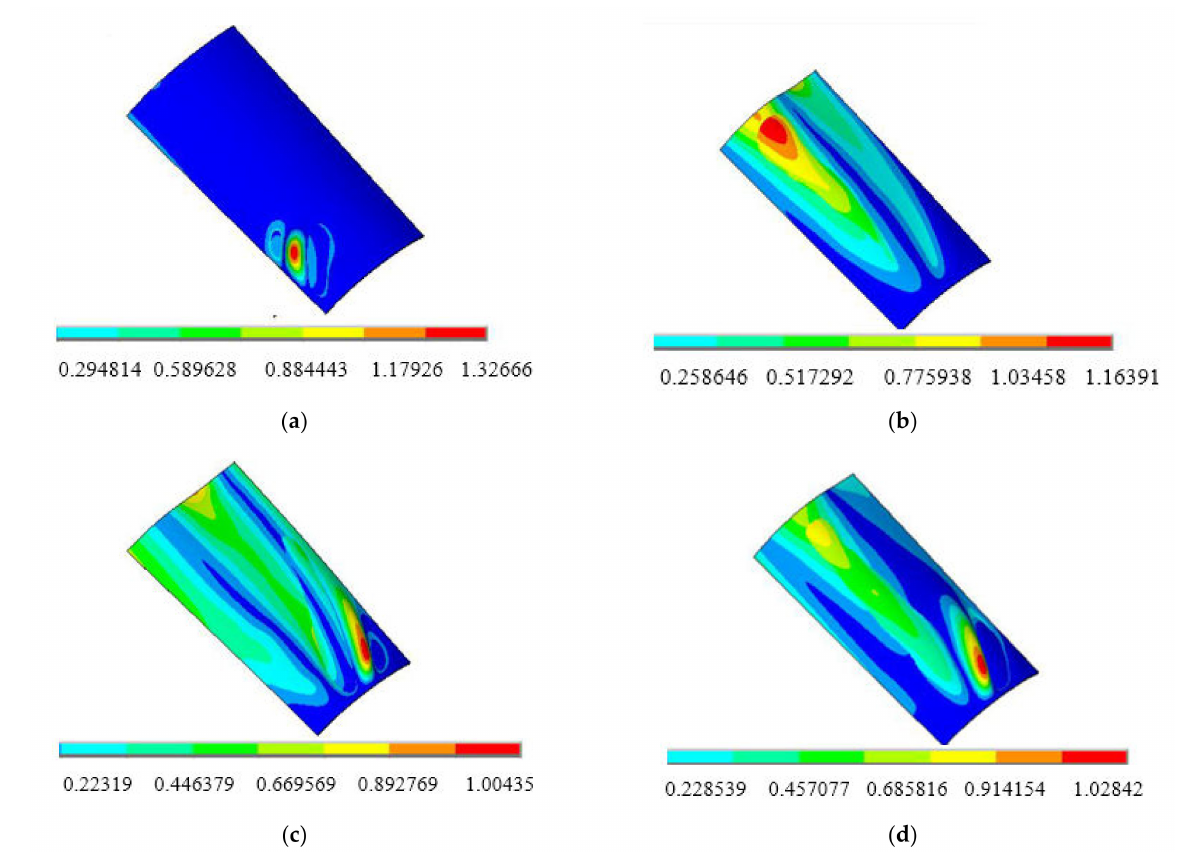
Figure 9. The linear buckling modes of blades [1]. ( a ) The first-order mode; ( b ) the second-order mode; ( c ) the third-order mode; and ( d ) the fourth-order